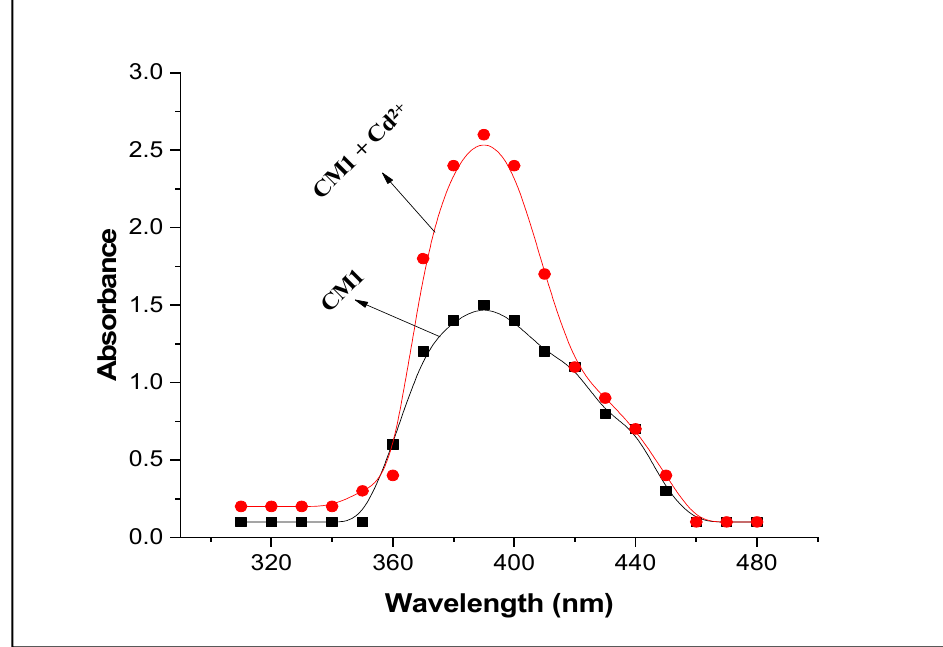
Figure 2 . Absorption study of CM1 (10 µM) and CM1 complex with Cd 2+ (18 µM) . Figure 2. Initial fluorescence study CM1 (10 µ M) and metal ions (200 µ M), at λ ex = 390 nm and λ em= 610